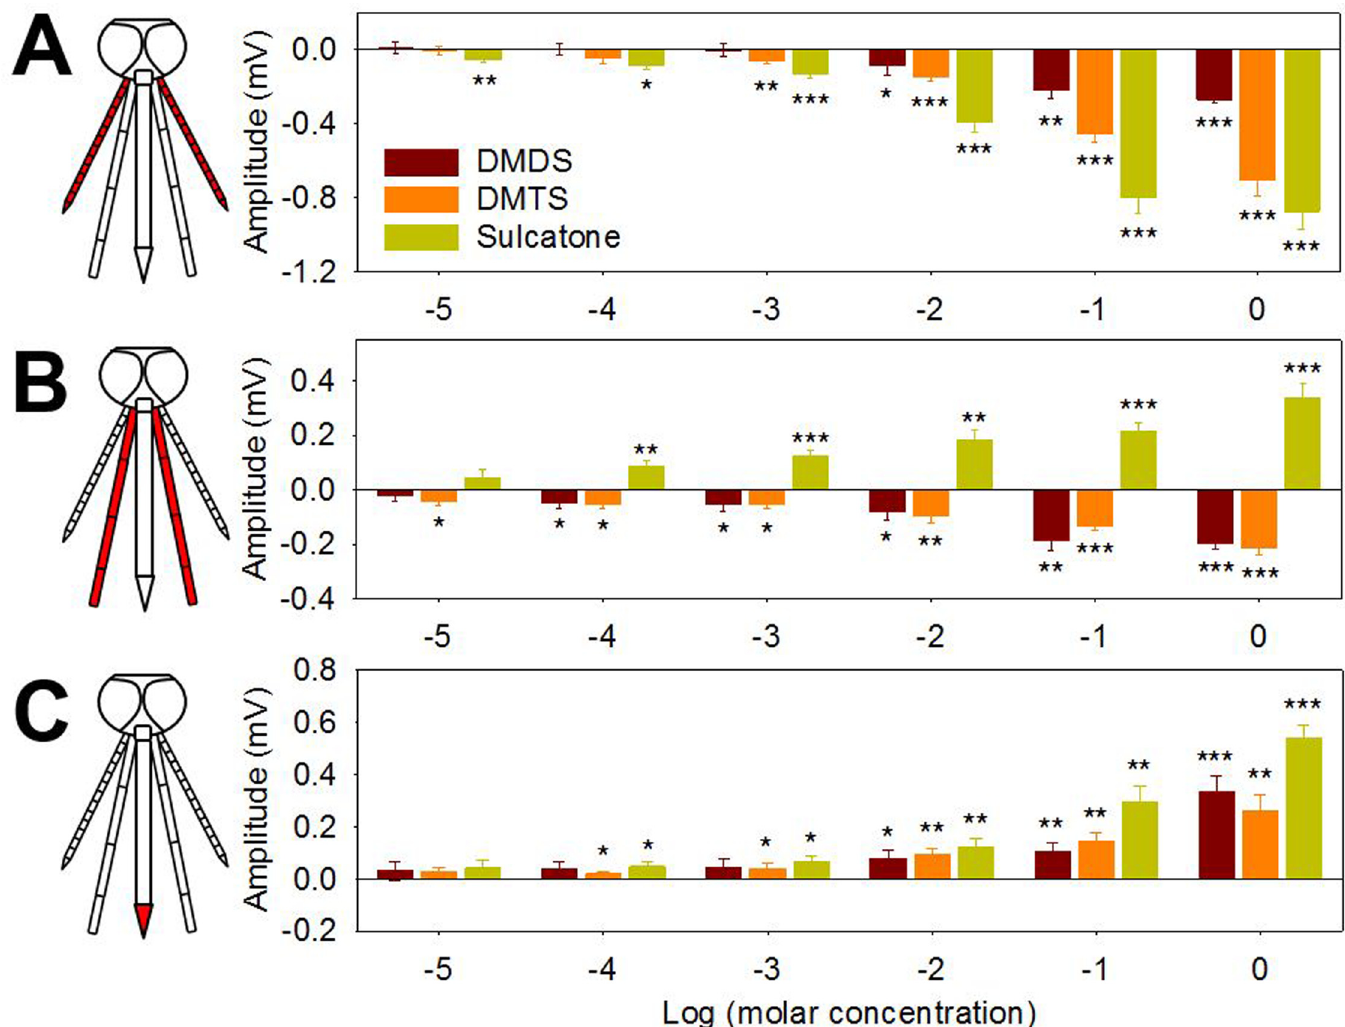
Fig 4. Chemosensory appendages of gravid An . coluzzii electrophysiologically respond to DMDS, DMTS and sulcatone. (A) EAG, (B) EPG and (C) ELG responses (each chemosensory organ is highlighted in red in a schematic diagram of mosquito head) are expressed as response difference to solvent control (oil) of An . coluzzii females to DMDS, DMTS and sulcatone. Y axis represents response amplitude subtracted by control values and X axis represents log transformed molar concentration. Asterisks represent significant response amplitude different from zero ( *** , p < 0.001; ** , p < 0.01; * , p < 0.05; one sample t -test, one-sided). Error bar = s.e.m. (n = 7).